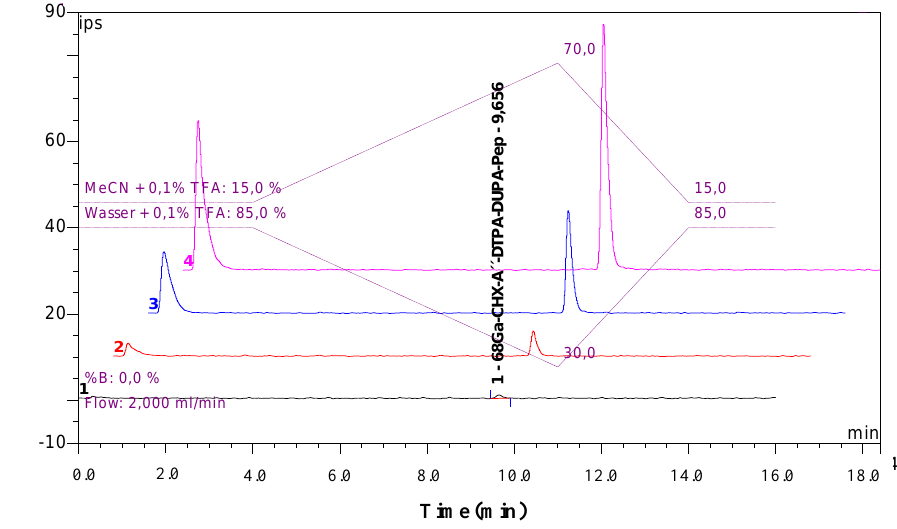
Figure 5. Stability study of [ 68 Ga]Ga-CHX-A''-DTPA-DUPA-Pep in human serum: overlaid radio-HPLC chromatograms after 8 h (1), 4 h (2), 2 h (3) and 30 min (4). The first peak shows the total activity injected (the detector bypass for the recovery rate